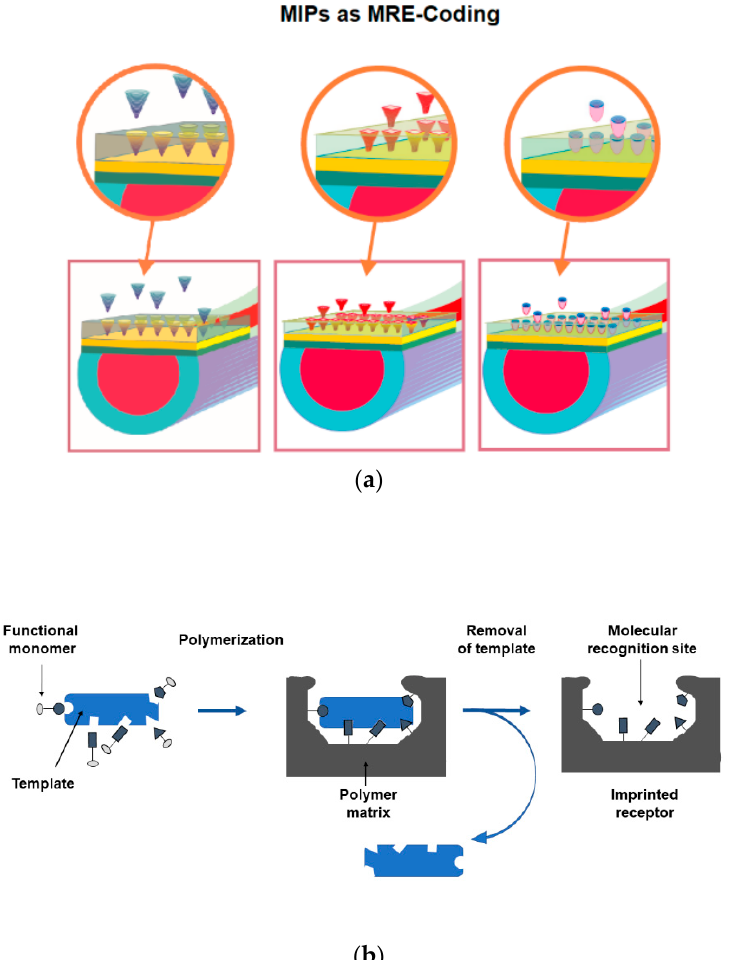
Figure 2. ( a ) Scheme of a general-purpose SPR-POF platform combined with different MIPs, as a versatile approach for optical-chemical sensing. ( b ) Outline relative to MIP’s realization process.